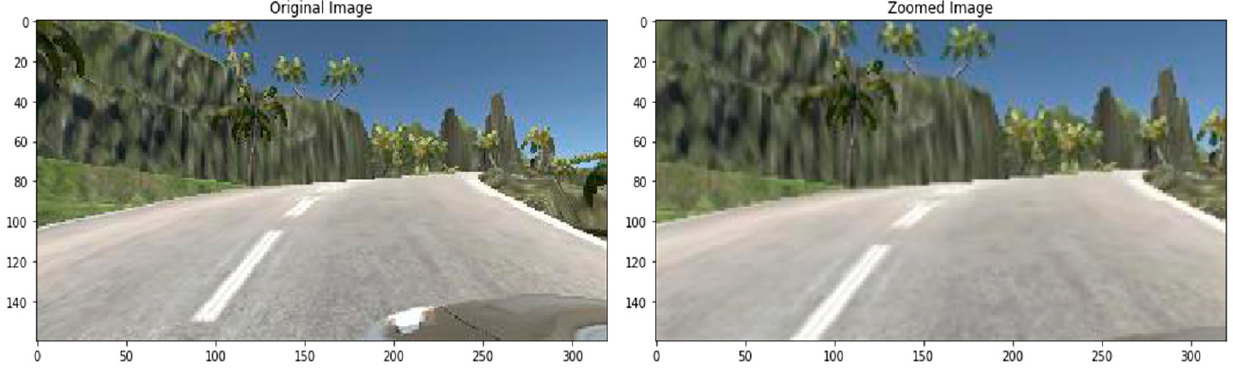
Figure 10. Normalized form of the dataset.